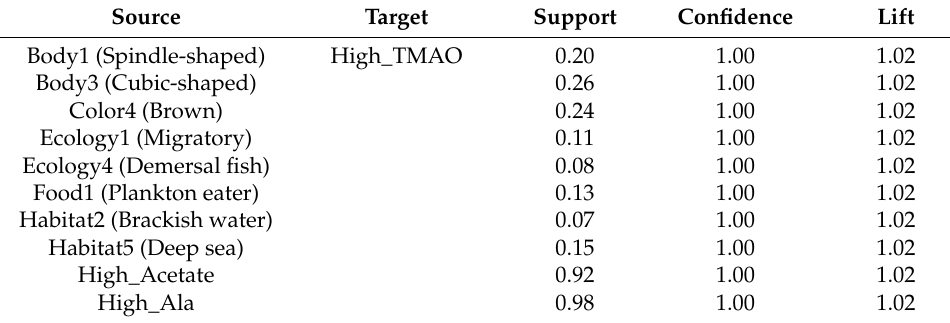
Table 5. Extracted association rules to high